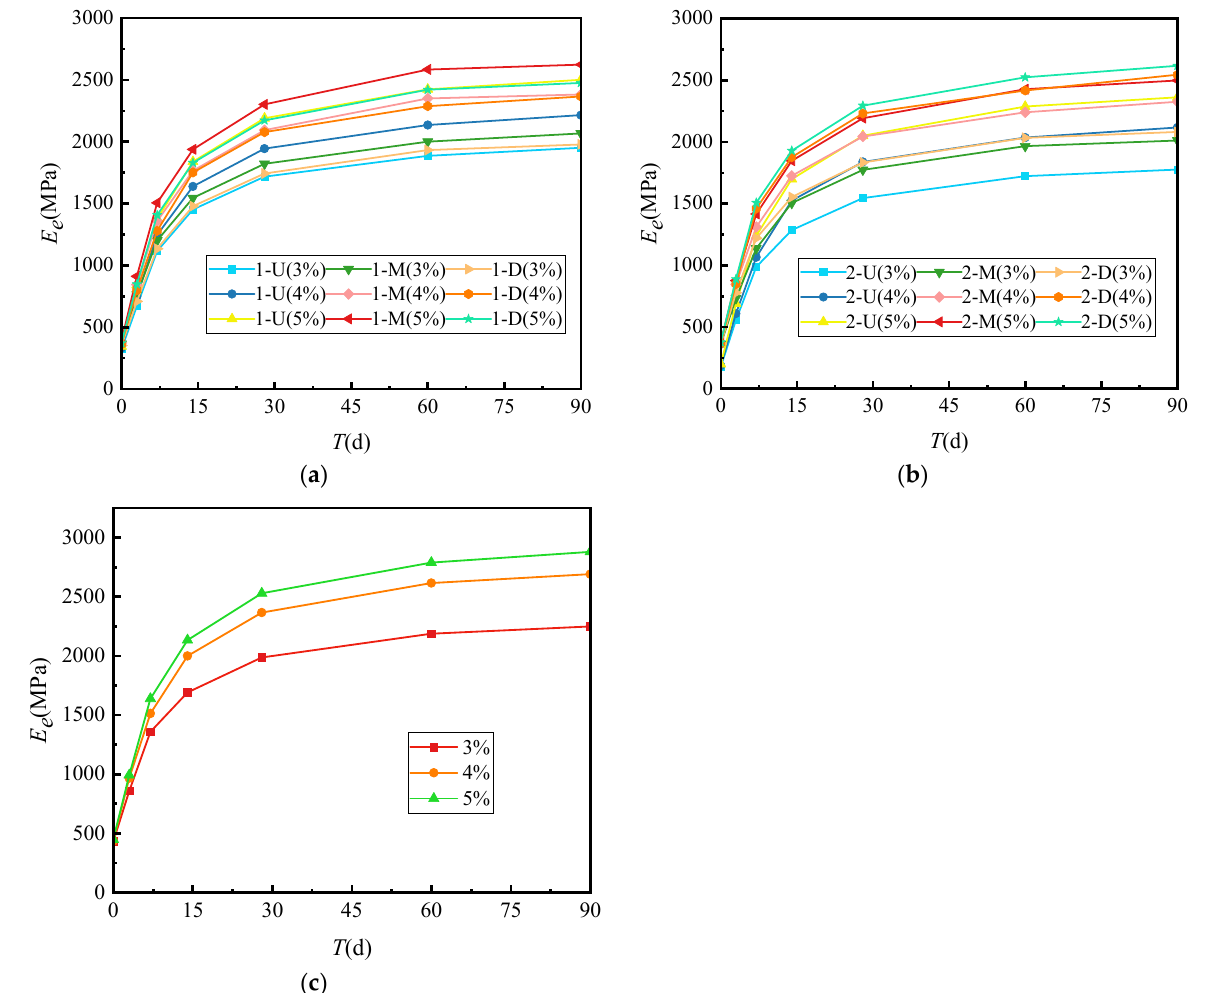
Figure 4. Growth law of resilience modulus. ( a ) GF1, ( b ) GF2, ( c ) VGM-30.